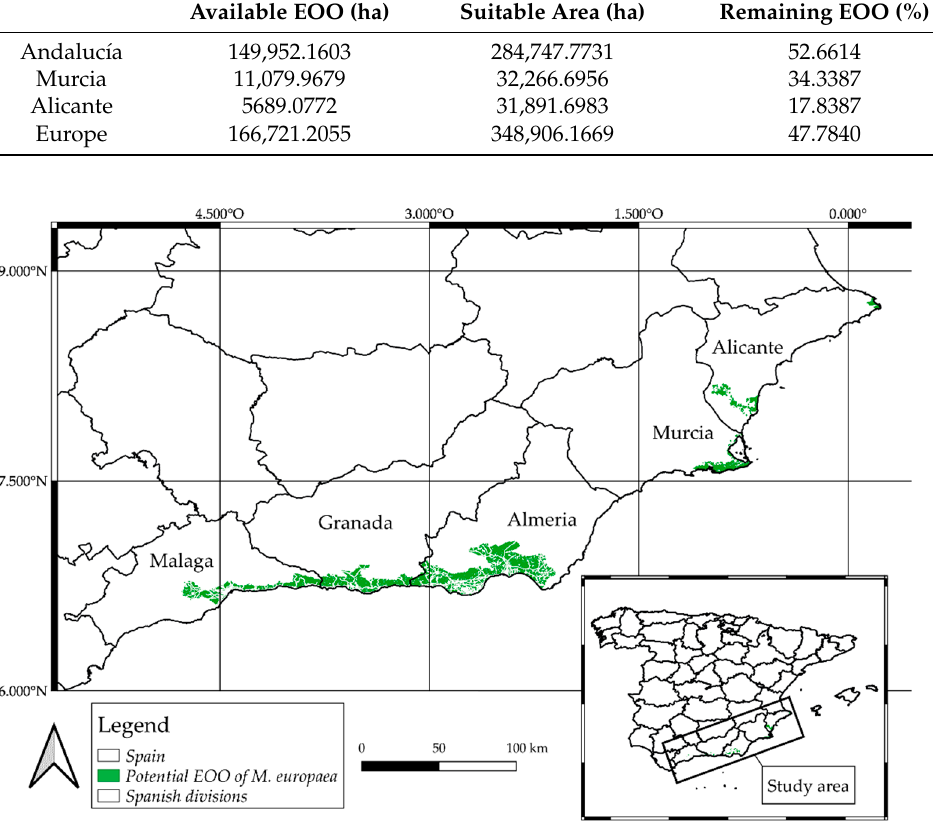
Figure 2. Plots of potential habitat of M. europaea in the past. ( a ) Interglacial Maximum (ca. 120 ka BP); ( b ) LMG (ca. 22 ka BP); ( c ) Mid ‐ Holocene (ca. 6 ka BP); ( d ) present. Table 2. EOO of M. europaea in Spanish provinces and Europe. Values calculated from SIOSE project.